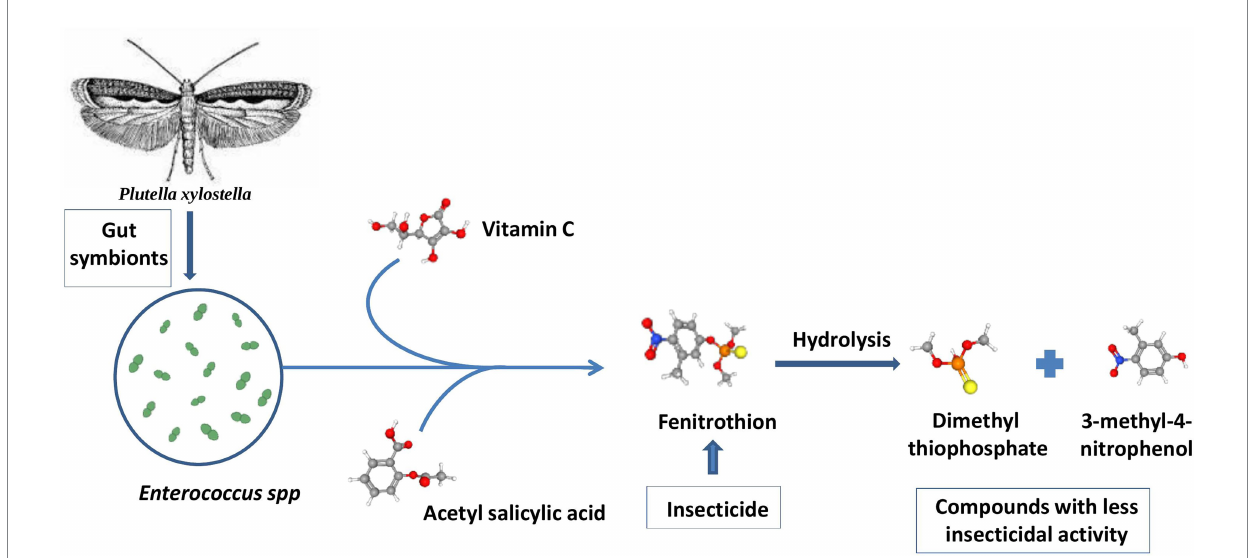
FIGURE 7 Pesticide degradation by gut symbionts in Plutella xylostella : The gut lining of Plutella xylostella is occupied with the gut endosymbiont Enterococcus spp. that degrades phosphate-based pesticides like fenitrothion into less harmful products such as 3-methyl-4-nitrophenol (Hayatsu et al., 2000; Xia et al., 2018).